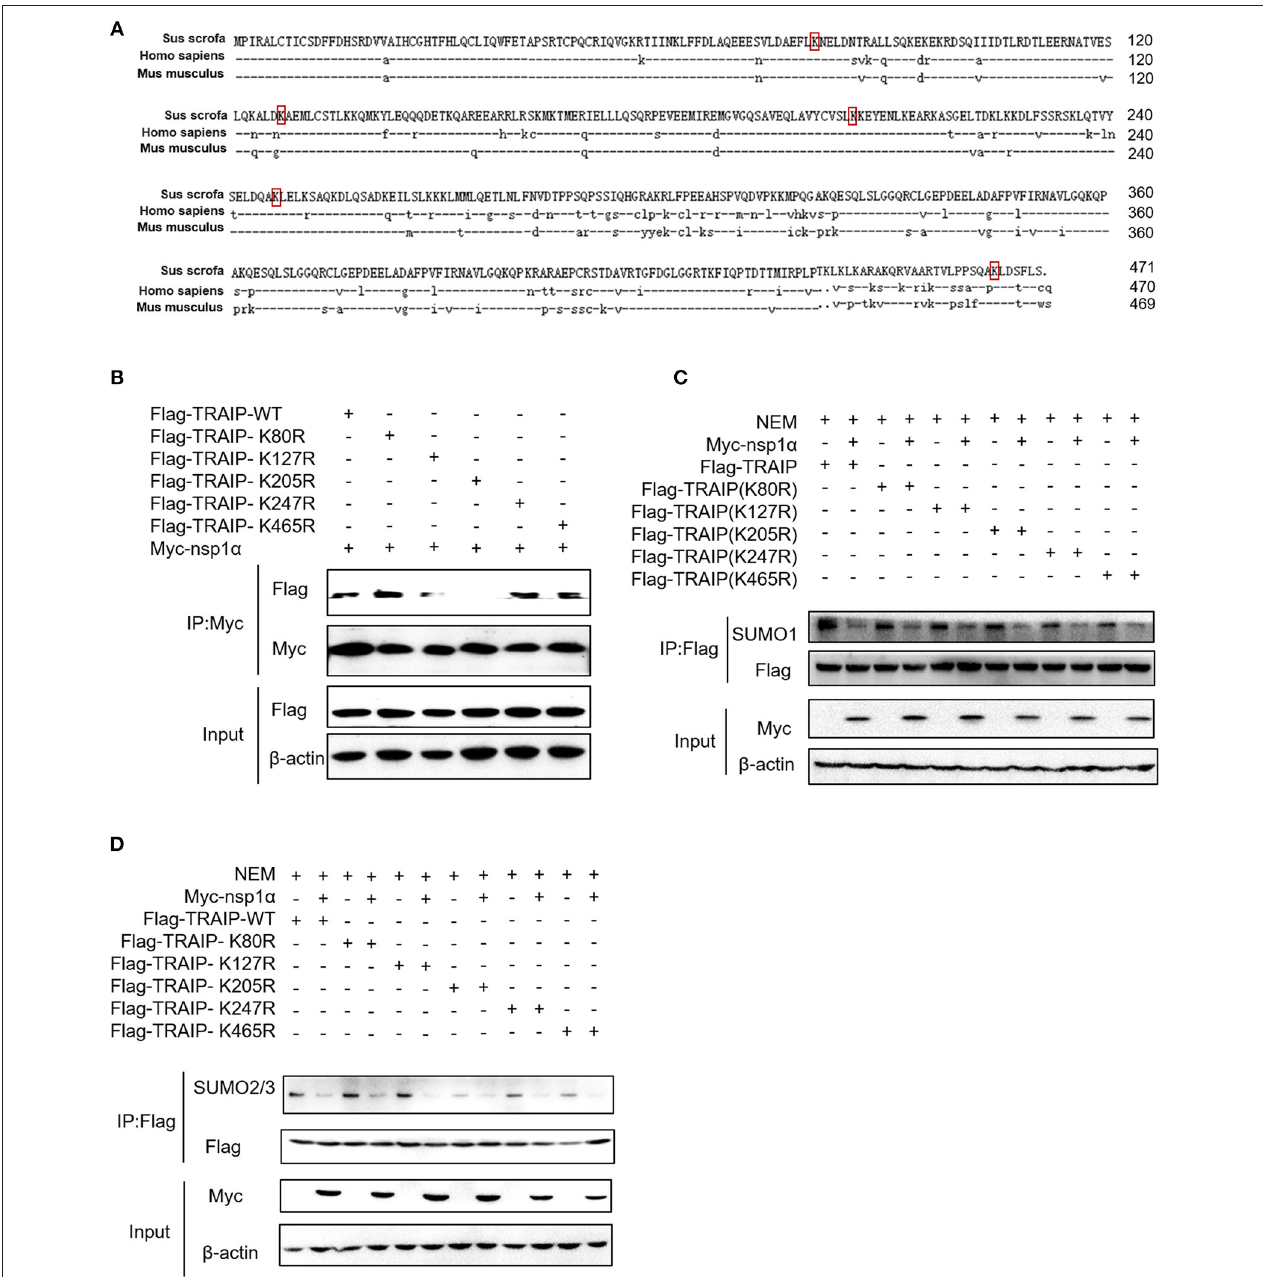
FIGURE 6 | The effect of nsp1 α on SUMOylation of TRAIP is independent of their interaction. (A) Sequence comparison of TRAIP and homologs from other species. The TRAIP cDNA encoded an ORF with 471 amino acid-long protein, GeneBank Accession XM_021068793.1. Porcine TRAIP amino acid sequence was compared with those from Homo sapiens TRAIP (NM_005879.2), Mus musculus (NM_011634.3), respectively. (B) Coimmunoprecipitation analysis of TRAIP K205R SUMO site interacts with Myc-nsp1 α in HEK293T cells. (C,D) HEK 293T cells were cotransfected with Myc-nsp1 α and Flag-TRAIP or different point mutants, and the effect of nsp1 α on endogenous TRAIP SUMO modification was detected by